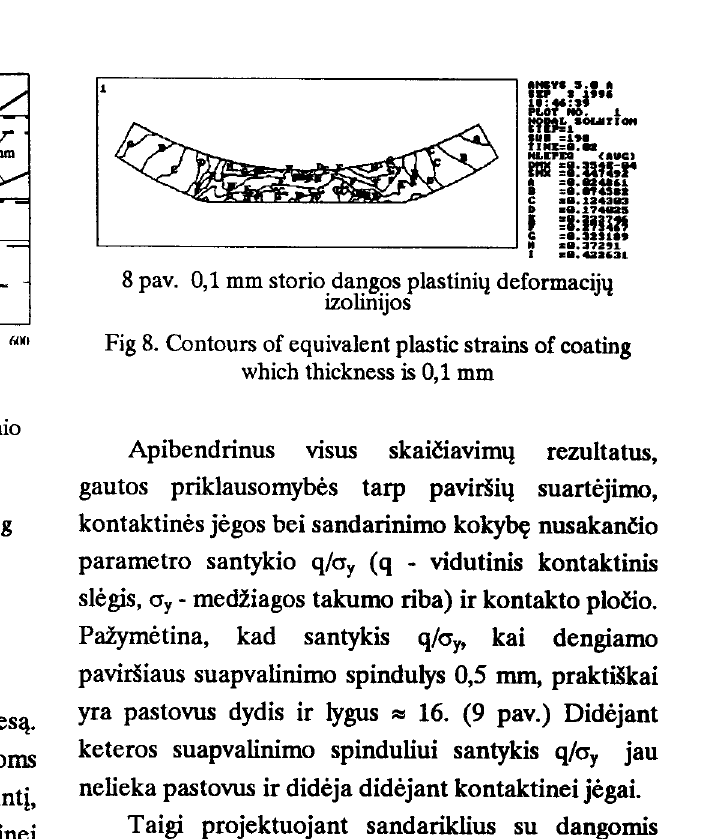
Fig 8. Contours of equivalent plastic strains of coating which thickness is 0,1 mm